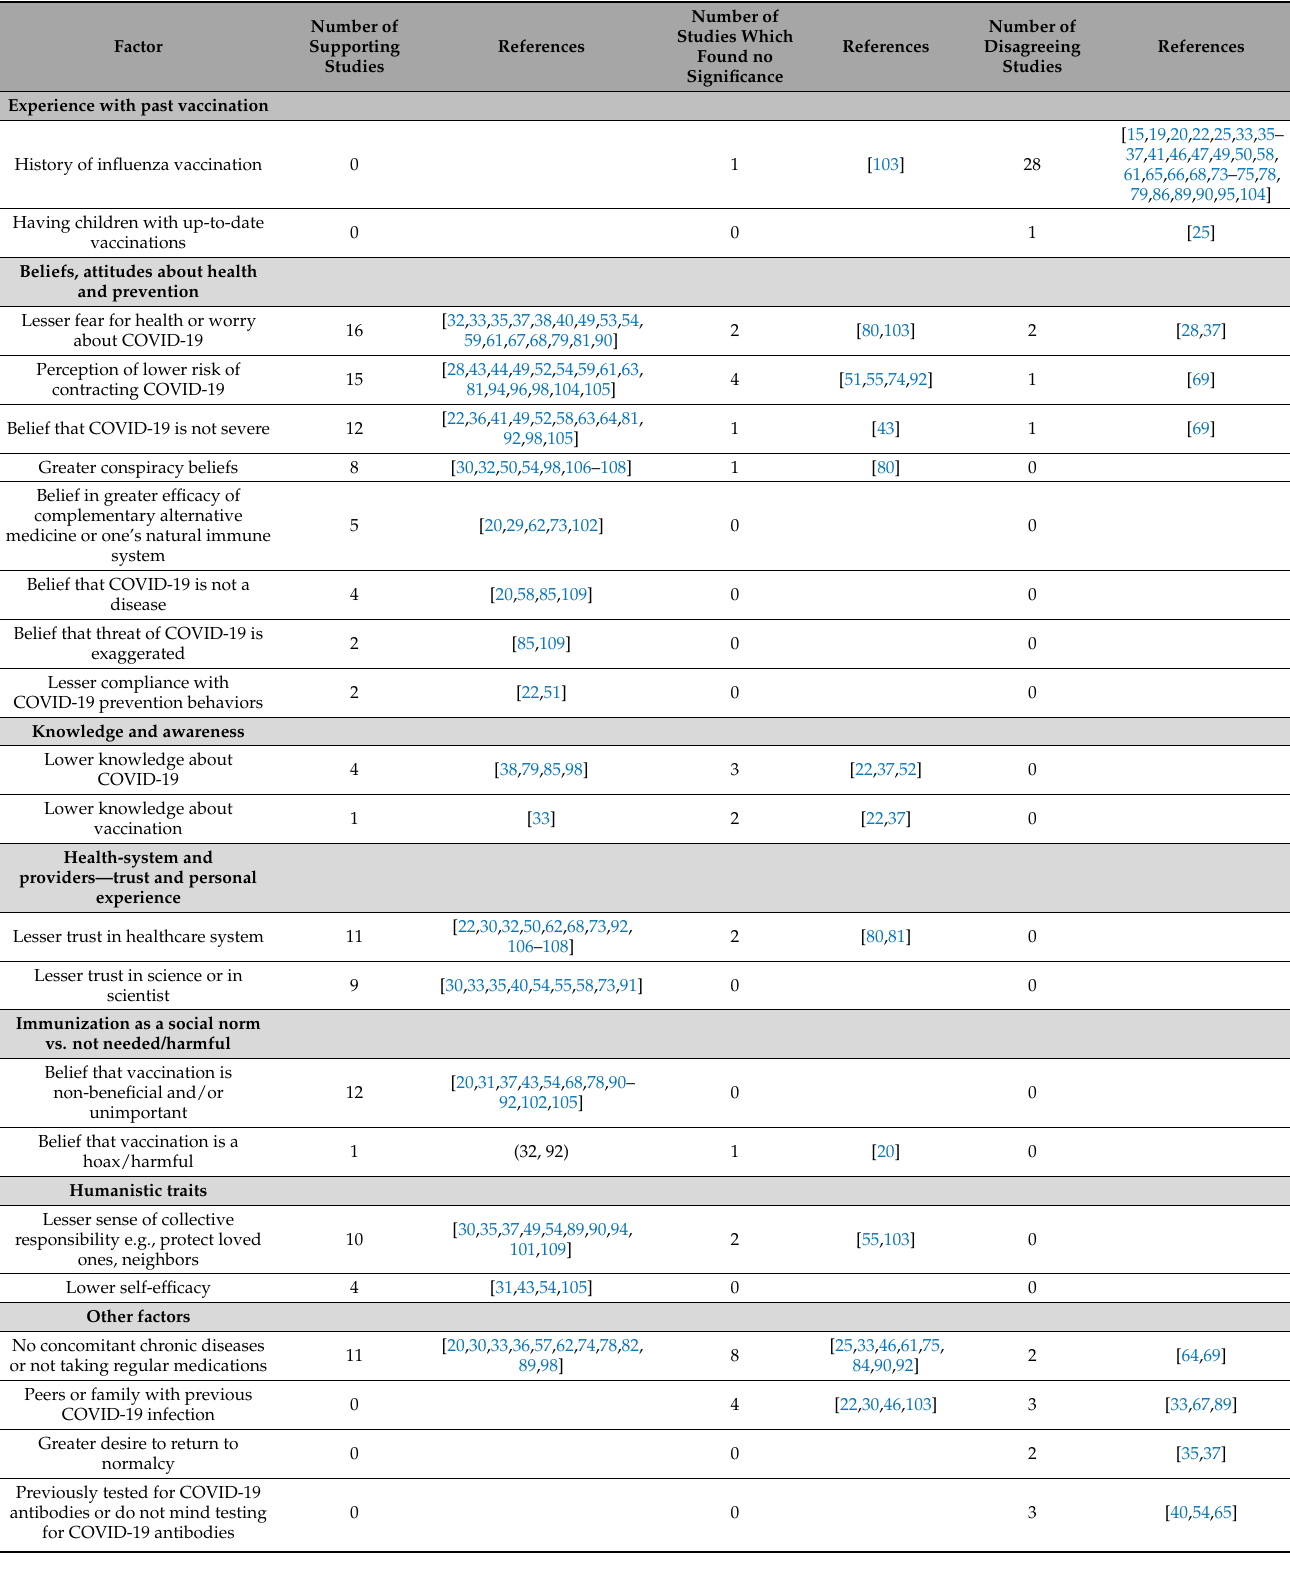
Table 3. Individual/group determinants of increased vaccine hesitancy in high-income countries or regions.